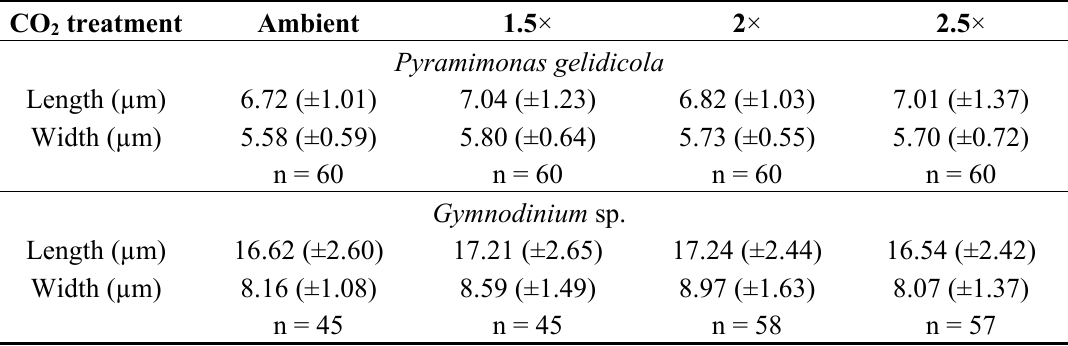
Table 2. Pyramimonas gelidicola and Gymnodinium sp. cell dimensions of the respective treatments. SD in brackets, n = number of samples. CO 2